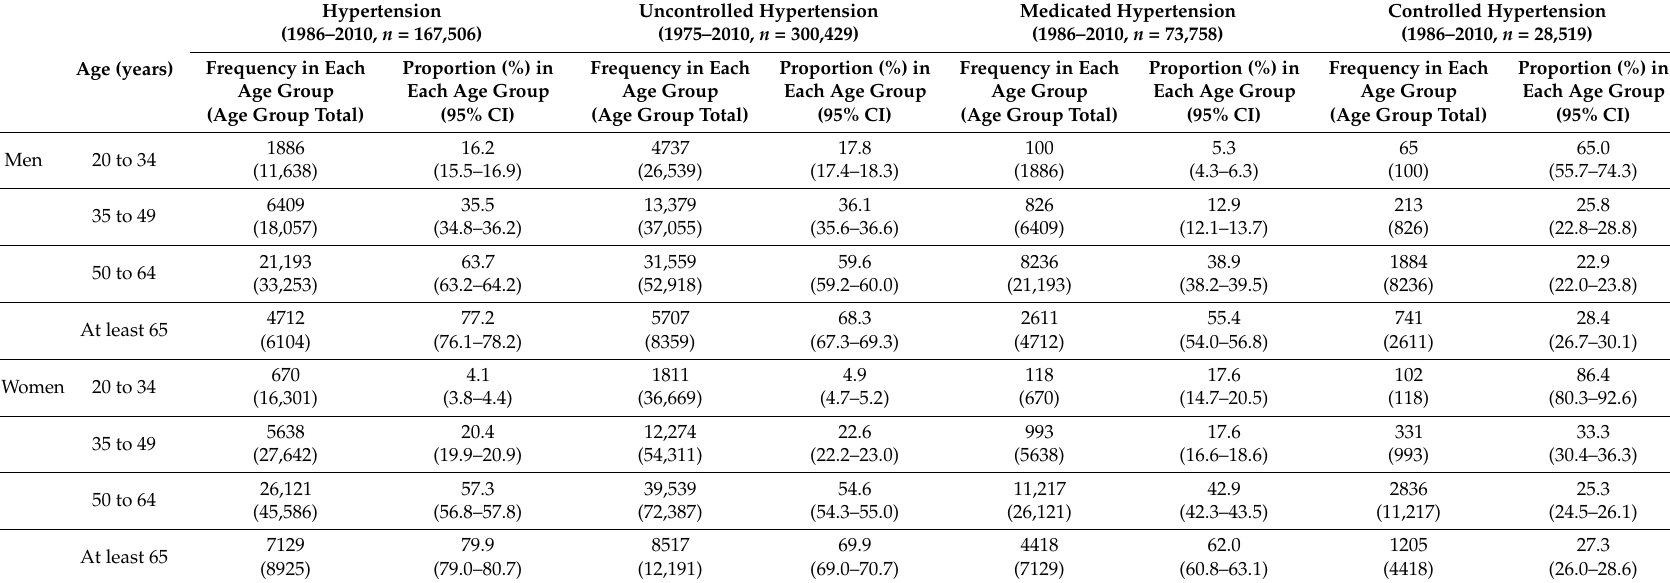
Table 2. The prevalence of hypertension (1986–2010) and the proportions of individuals with uncontrolled hypertension (1975–2010), medicated hypertension (1986–2020) and controlled hypertension